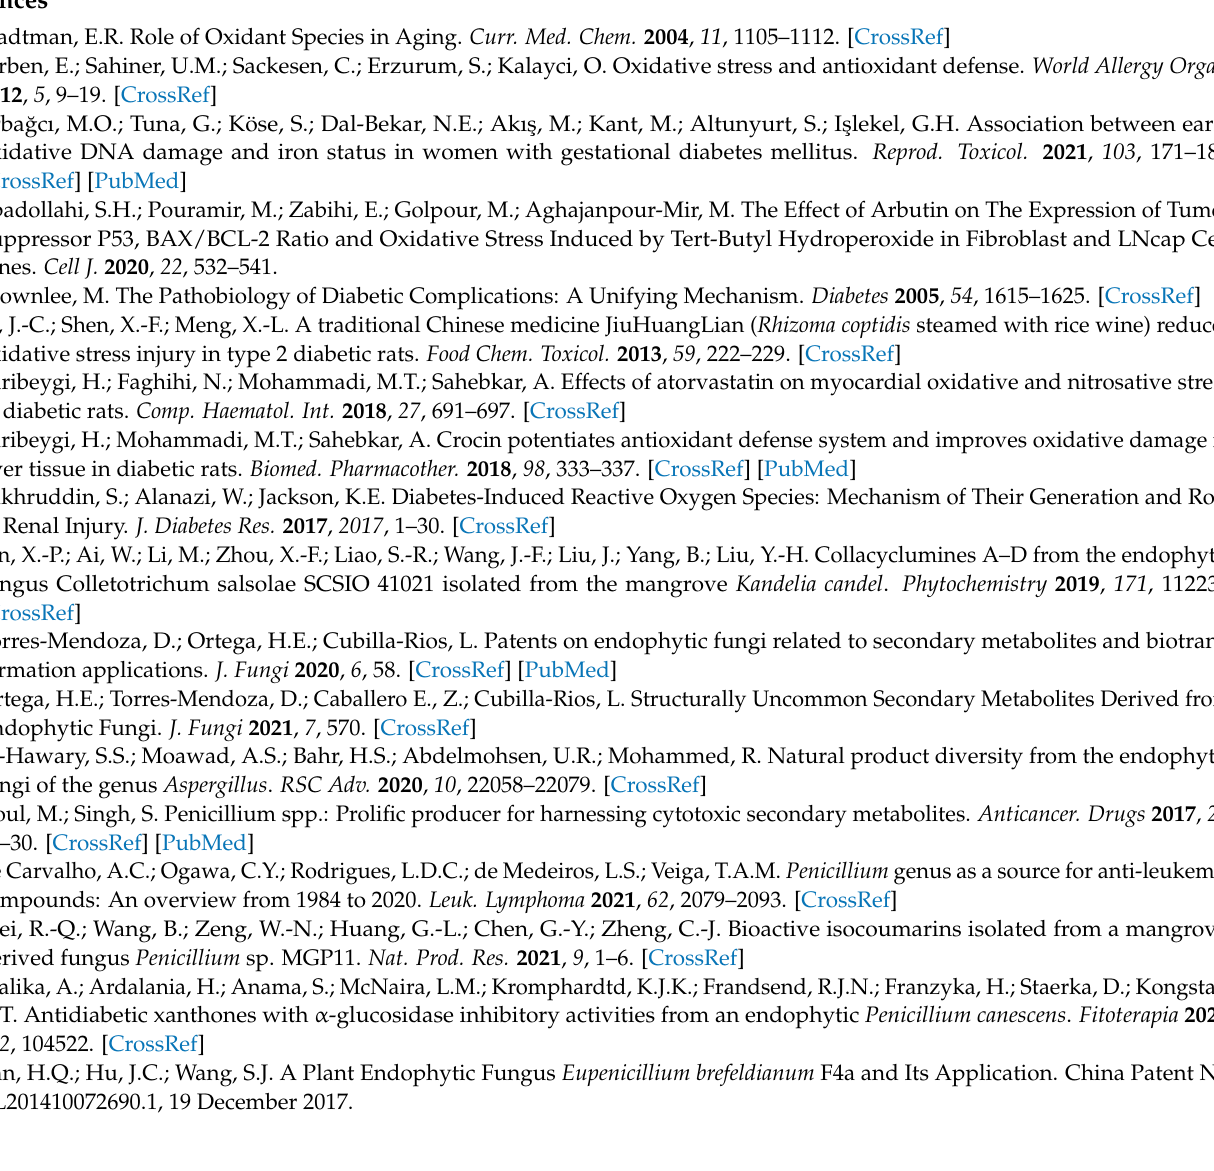
3 , Figure S19: 1 H- 13 C HMBC spectrum of compound 3 , Figure S20: 1 H- 1 H COSY spectrum of compound 3